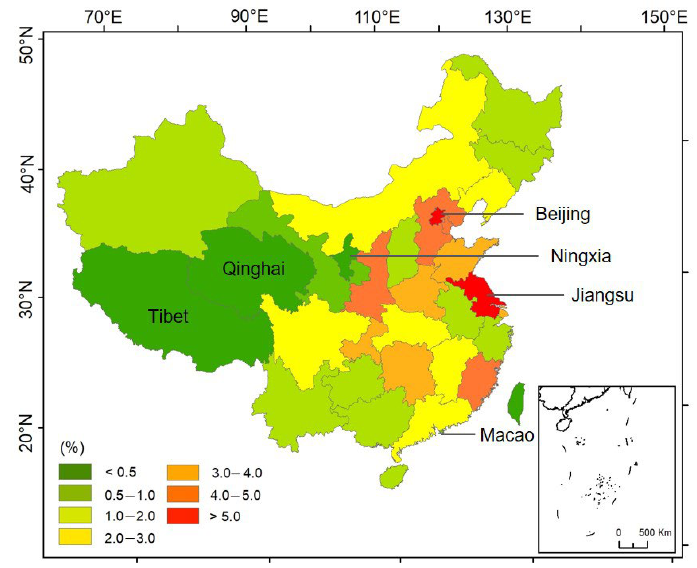
Figure 1. The percentages of studies focused on the Chinese Spring Festival by region.